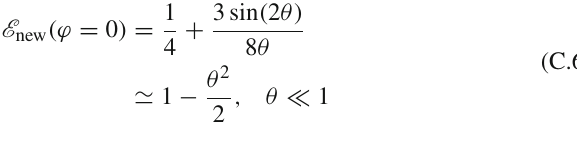
Fig. 4 Schematicillustratinghowaquadrupoleanisotropyintheback- ground population can enhance the probability of ν H being emitted in a direction as aligned as possible with the principal axis of anisotropy. Observe in this example that the emitted ν H is misaligned with the principal axis of anisotropy by an angle ∼ θ . This small misalignment leads to a distribution of random walkers after one coverage time T 2 (Eq. (C.3)) that is slightly dispersed relative to the distribution of the background population, i.e., the walker population (red line in the right